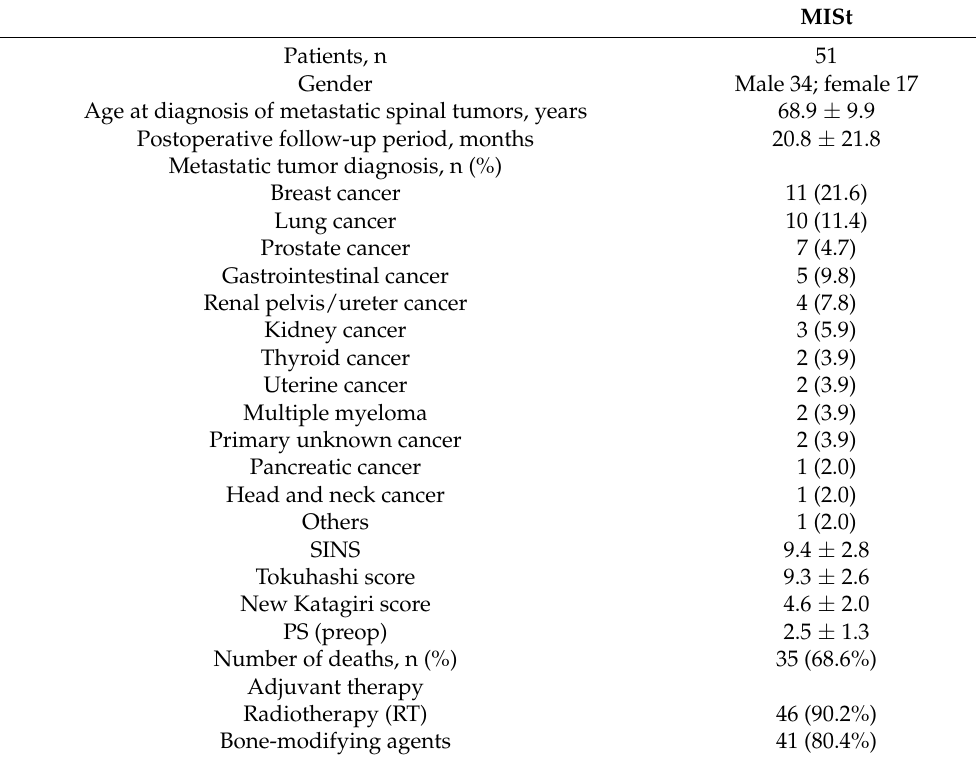
Table 1. Detailed clinical characteristics and results of patients with metastatic spine tumors who underwent MISt surgery.